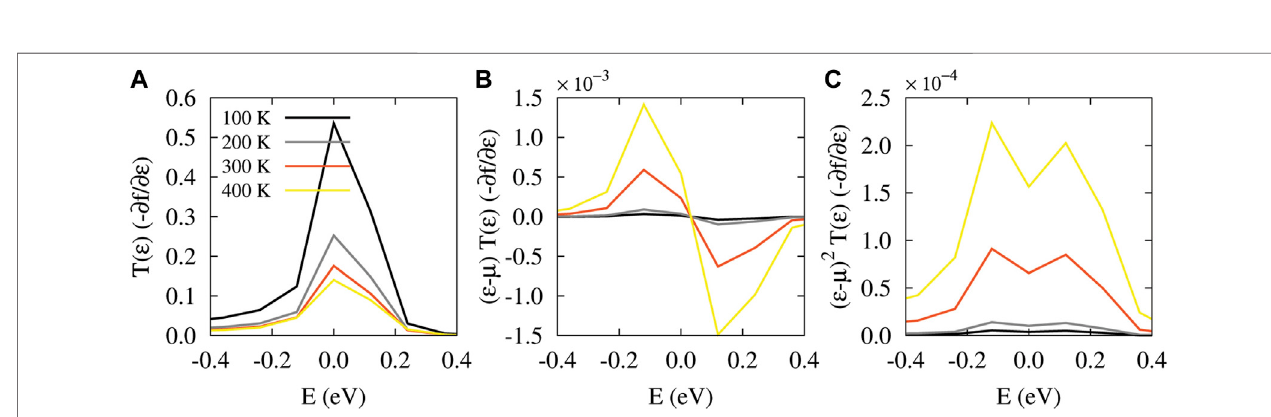
FIGURE 2 | (A) The transmission spectrum versus energy for the unperturbed anthracene molecule coupled to the Au electrodes via thiol (red), isocyanide (blue) and cyanide (green) anchoring groups which was evaluated at T (cid:1) 300 K. HOMO/LUMO transmission peaks are labeled by letter H/L. Temperature dependency of the electrical conductance (B) , electronic thermal conductance (C) , thermopower (D) and fi gure of merit (E) in the unperturbed molecular junction. Colored arrows indicate that the corresponding curve is depicted against y2-axis (right) .